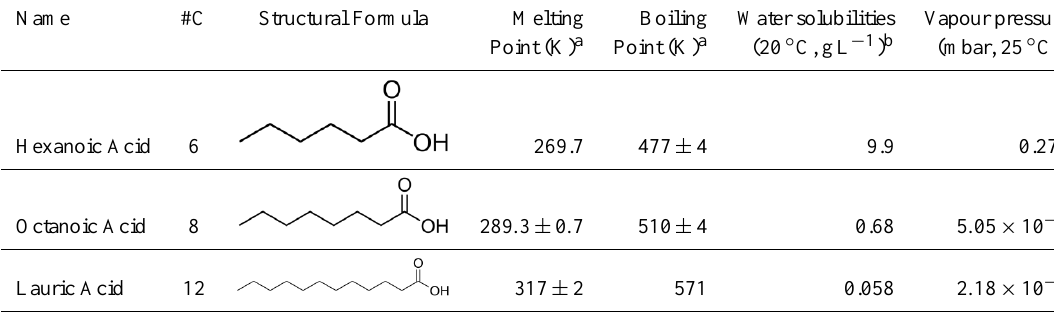
Table 1. Physical properties of the studied carboxylic acids.